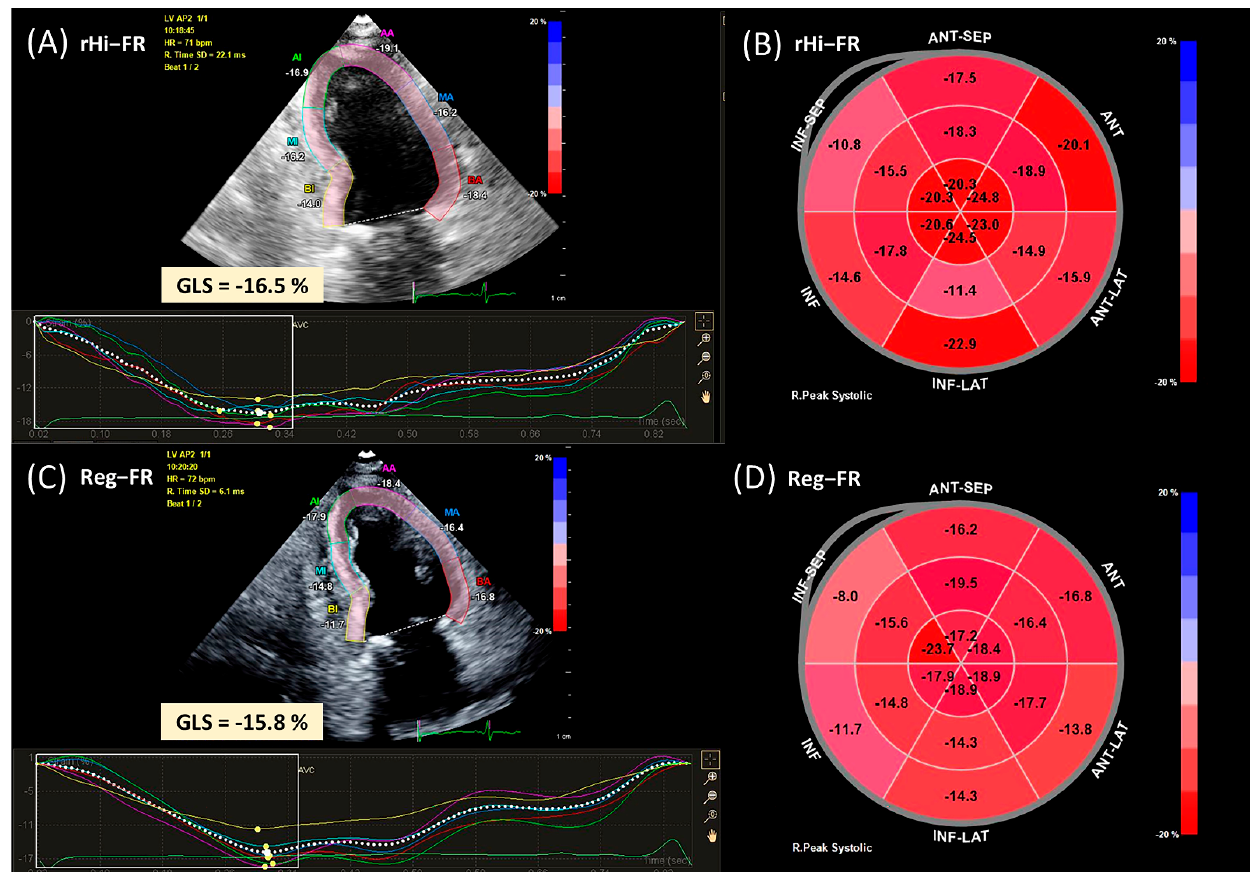
Figure 1. Samples of speckle ‐ tracking analysis. Strain values were evaluated in ( A , B ) rHi ‐ FR and ( C , D ) Reg ‐ FR. rHi ‐ FR, relatively high frame rate; Reg ‐ FR, regular frame rate.